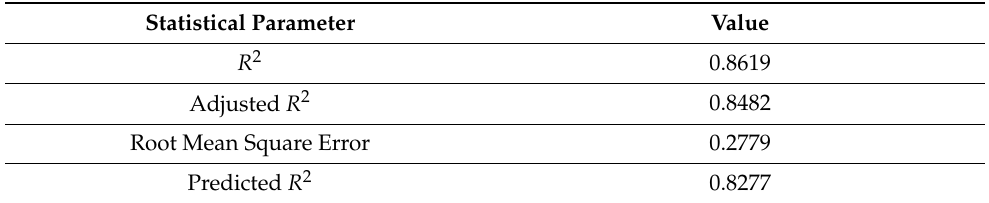
Table 3. Summary of the process model statistical parameters.